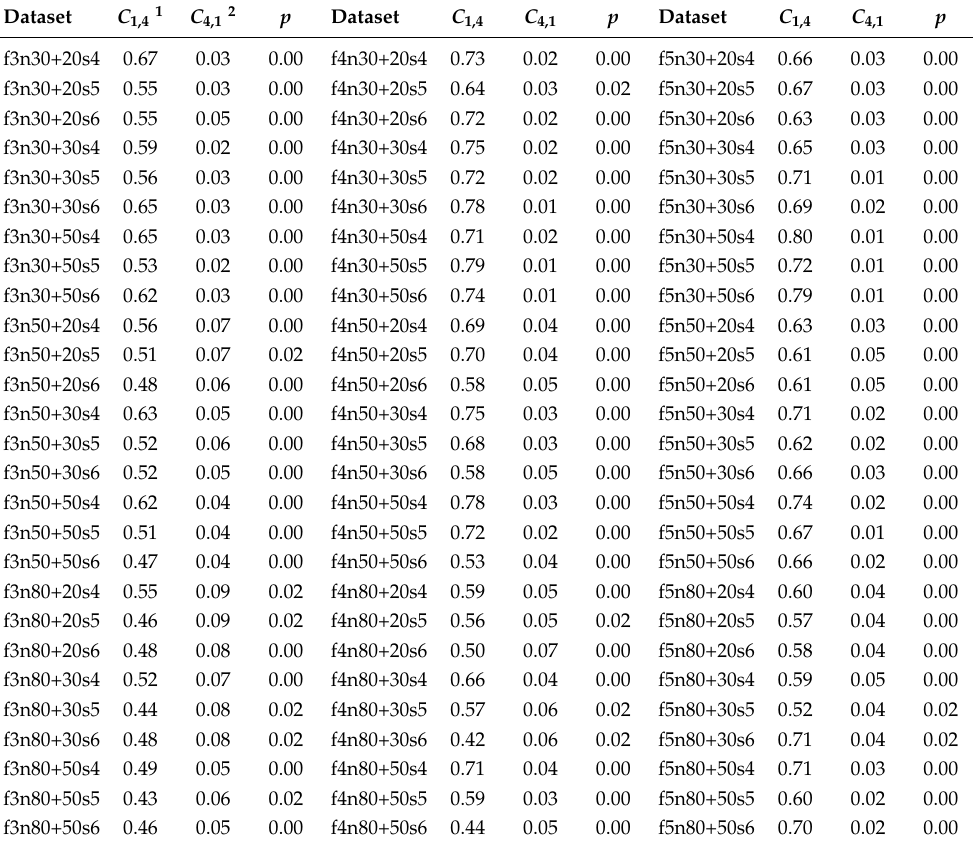
Table 6. Average C Metric Values of KCDE and